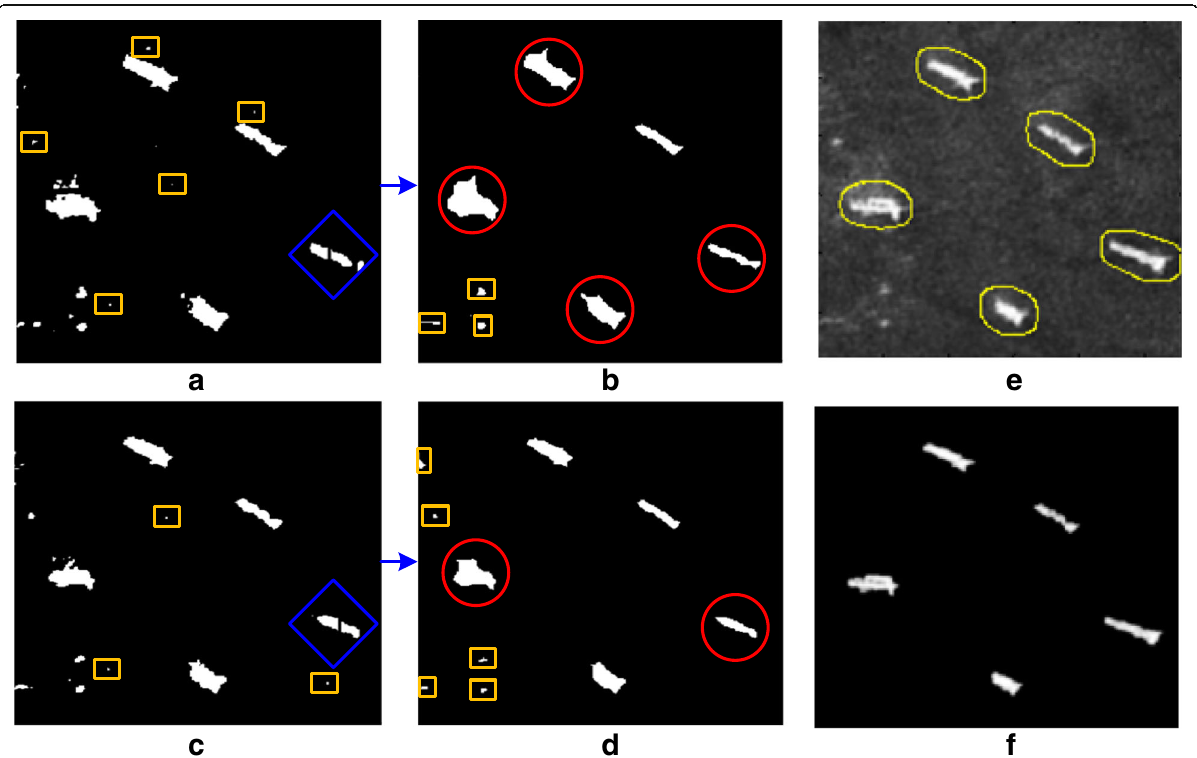
Fig. 11 The detection results based on the three detection algorithms for comparison. a CFAR detection result based on gamma distribution. b Morphological processing. c Detection result based on two-parameter CFAR. d Morphological processing. e VA-SVD detection result. f The proposed detection result algorithm